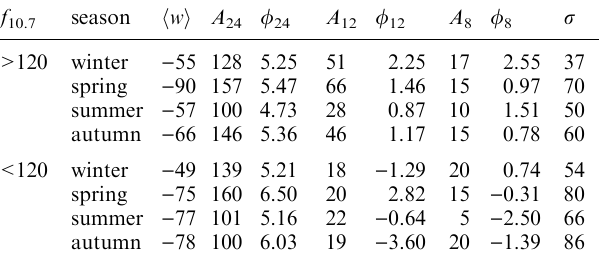
Table 9. Harmonic decomposition at 257 km height f 10.7